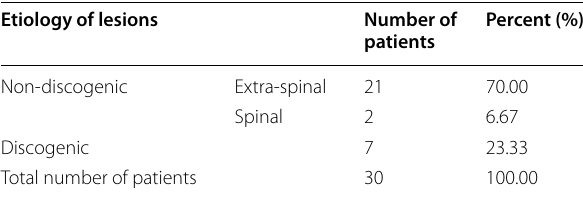
Table 2 Distribution of the studied cases according to etiology of lesions ( n =